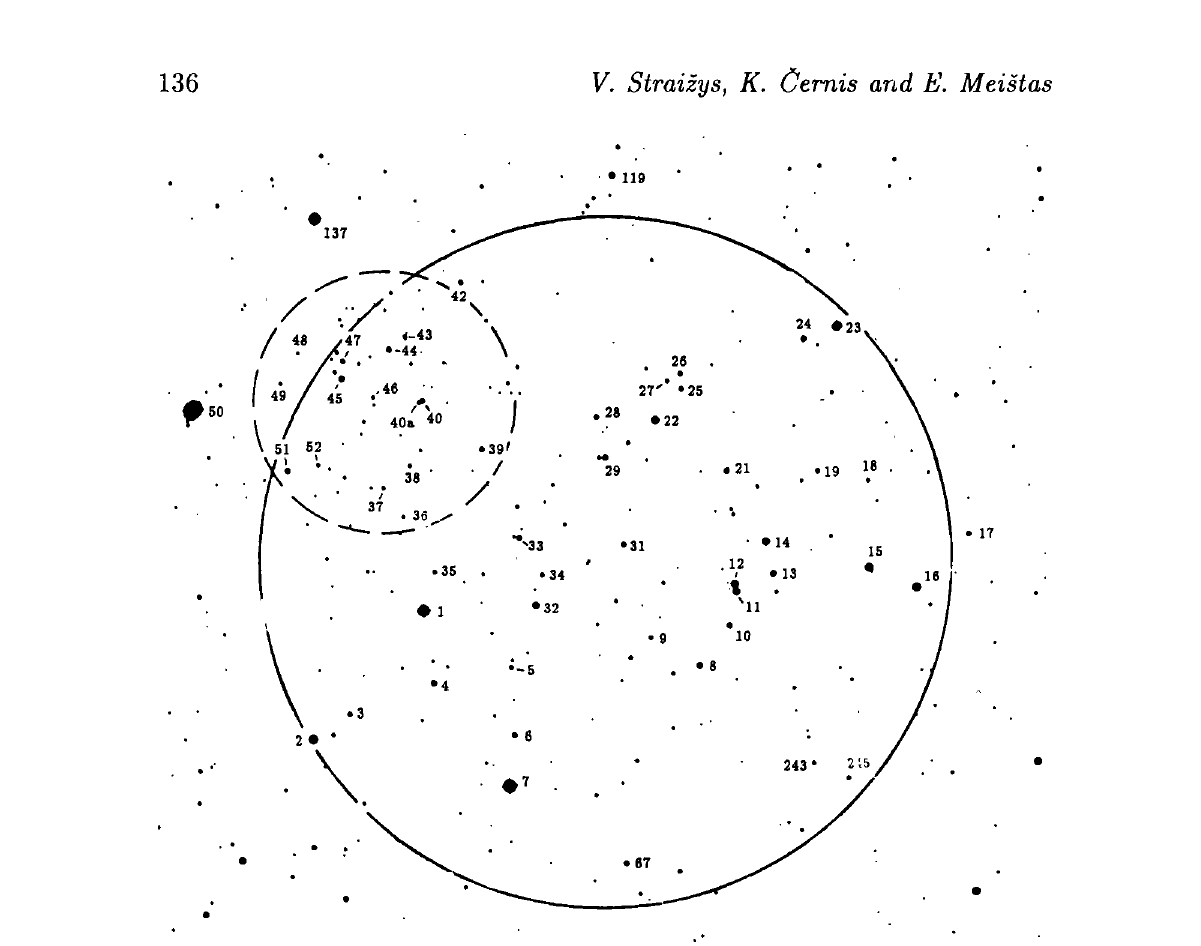
Fig. 2. Identification chart of stars in the areas of NGC 1750 (bigger circle) and NGC 1758 (smaller circle). Diameters of the circles are 28' and 8', respectively. Numbers of stars are from Cuffey (1937). The enlarged area of NGC 1758 see in Fig.